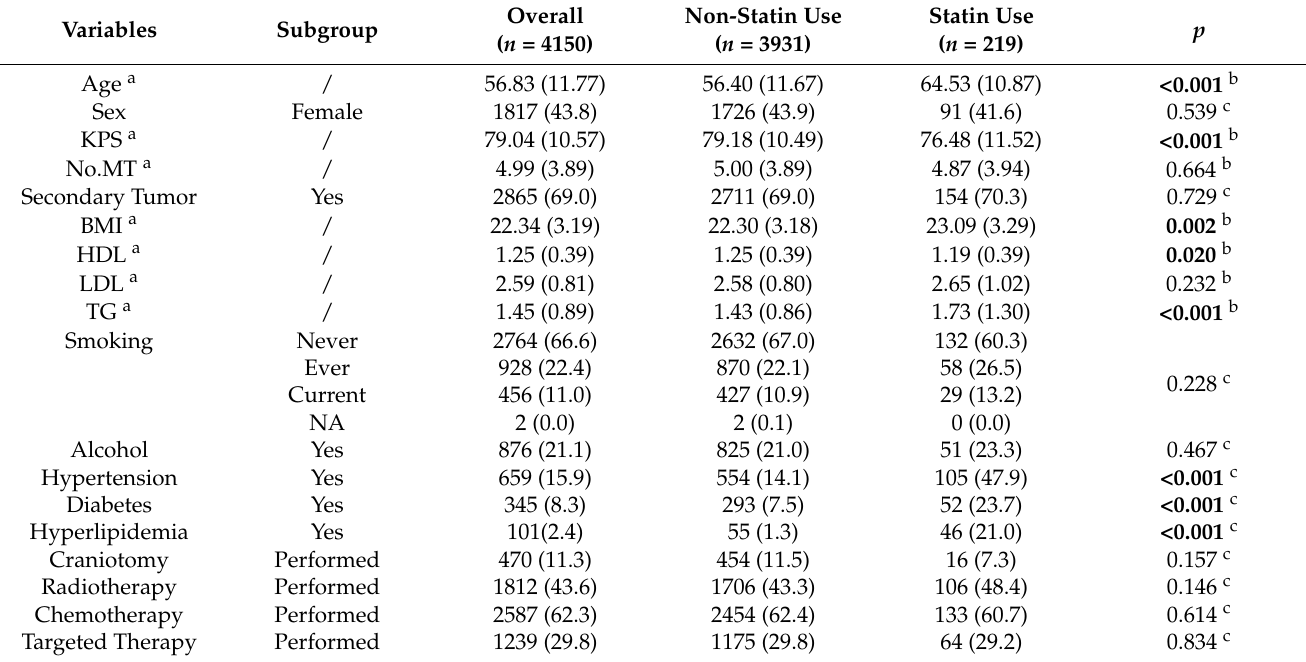
Table 1. The clinical demographic characteristics of the brain metastatic cancer patients in the present study.